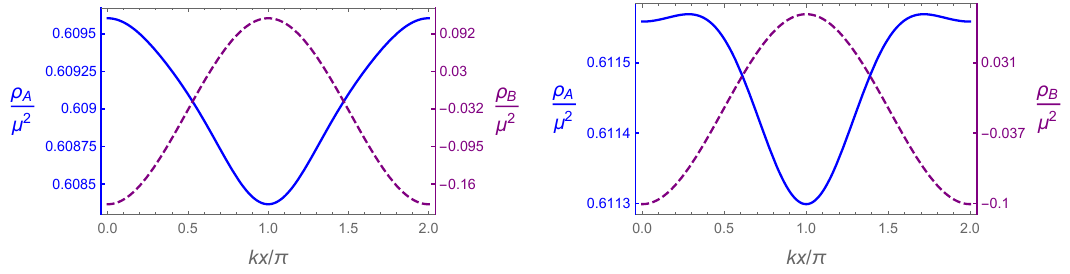
Figure 13 . The charge densities for q B = 0 : 5. We choose T = 0 : 01426 (left panel) and T = 0 : 01571 (right panel) with k =